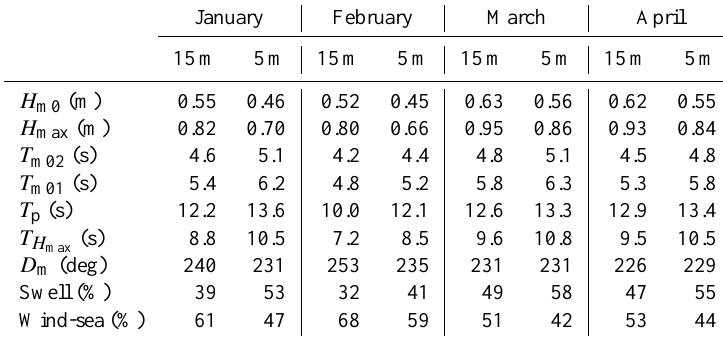
Table 1. Average value of wave parameters at 15 and 5m water depth in different months.